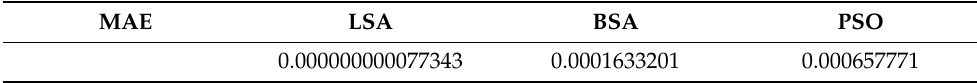
Figure 15. Variety in global optimum outcomes with MAE for load ( a ) 2 M Ω ; ( b ) 100 k Ω ; ( c ) 470 Ω ; ( d ) 50 Ω . Table 3. Estimations of outcome errors by different techniques.